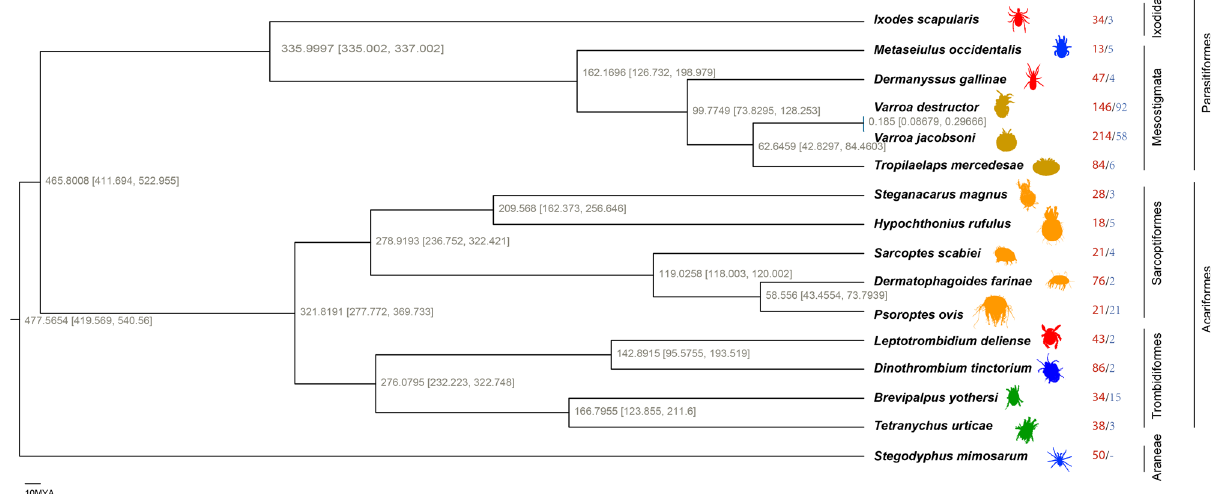
Fig. 1 The genome-wide phylogenetic tree of Arachnida. The divergence time was estimated based on a maximum likelihood phylogenomic tree of 16 Arachnida species and three fossil calibrations. All nodes have 100% support according to 1,000 bootstraps. The estimated divergence times are displayed with 95% con fi dence intervals (in square brackets). Blood-sucking species in red; fat-feeding species in olive; herbivorous species in green; predatory species in blue; and others/transitional in orange. The same colour theme is used in the other fi gures. The numbers to the right of the species indicate the records of gene family expansions and contractions, with red for expansions and blue for